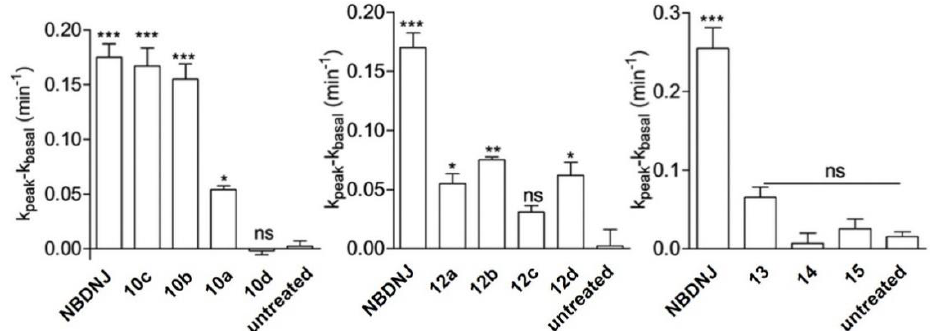
Figure 5. F508del-CFTR correction by saturated, unsaturated and fluorinated N -alkyl DNJ derivatives.